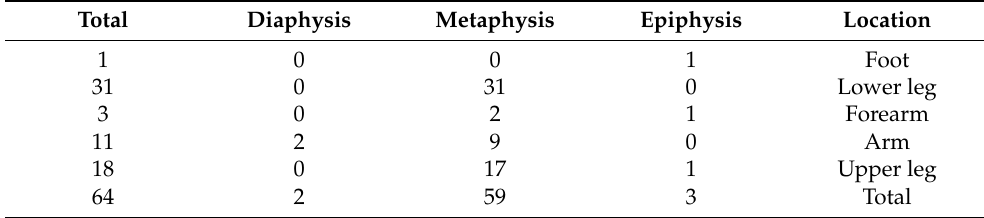
Table 4. Locations of